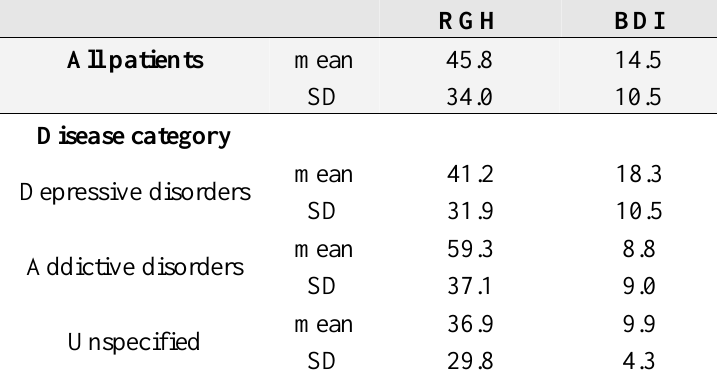
Table 1. Reliance on God‘s Help (RGH) and depression